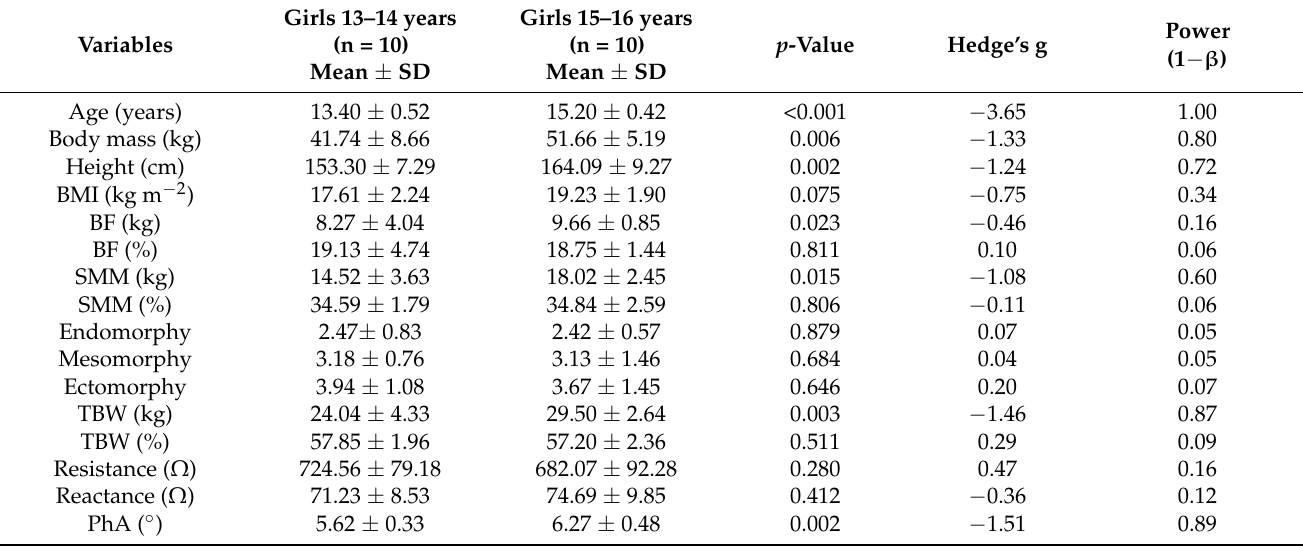
Table 3. Descriptive statistic and differences between the two group of